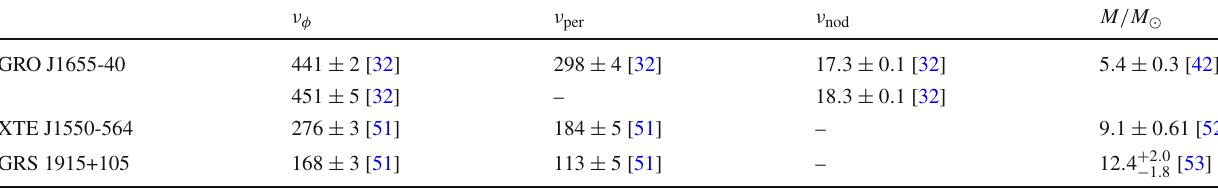
Fig. 4 The change of the frequencies ν φ , ν per and ν nod with the parameter l in the rotating black hole spacetime in Einstein-bumblebee theory. Here we set M = 1 and r = 6 . 5 Table 1 Data of quasi-periodic oscillations and black hole mass for GRO J1655-40, XTE J1550-564, and GRS 1915+105, respectively ν φ ν ν / M per nod M